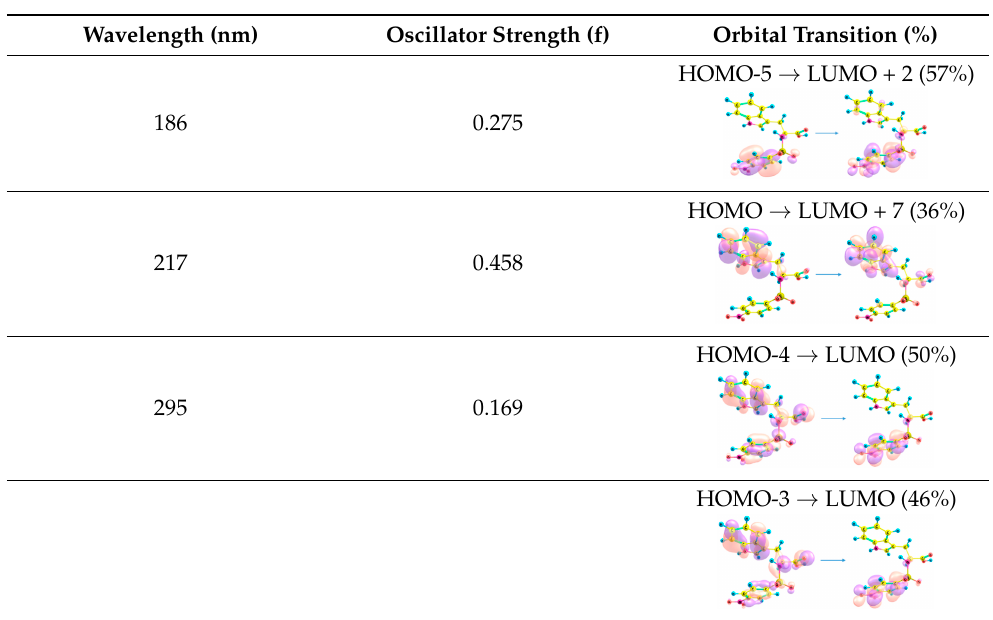
2.3. Vibrational Analysis Figure S2a,b display the experimental and simulated IR spectra. The computed vi- brational modes (cf. Table S5) were assigned based on potential energy distribution (PED) analysis using VEDA4 software [54,55]. The sulfonamide S-N stretching vibration mode is observed at 931 cm − 1 . This is in agreement with the computed vibrational mode ob- served at 847 cm − 1 and the reported vibrational mode of S-N stretching (935 cm − 1 ) [56]. The two vibrational modes of SO 2 fall within 1125–1330 cm − 1 [57,58]. The bands observed at 1330 and 1157 cm − 1 are due to asymmetric and symmetric stretching vibrations of SO 2, while the computed S=O stretching is observed at 1298 cm − 1 . Other vibrational modes of